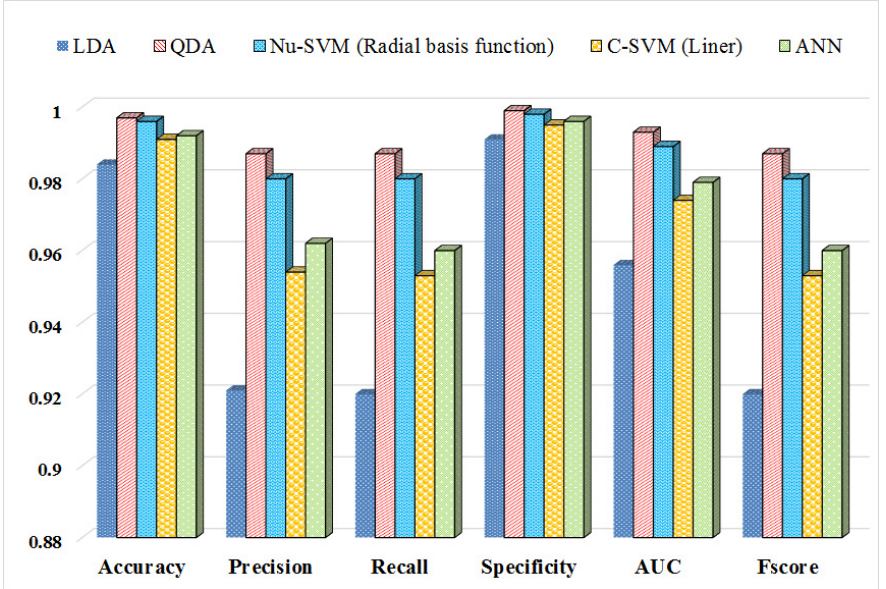
Figure 6. Average performance parameters of the statistical models in the classification of cucumber fruit sample data. Data comparisons are derived from e-nose VOC emission headspace volatile analyses, according to the rates of urea fertilizer applied in the test plots.